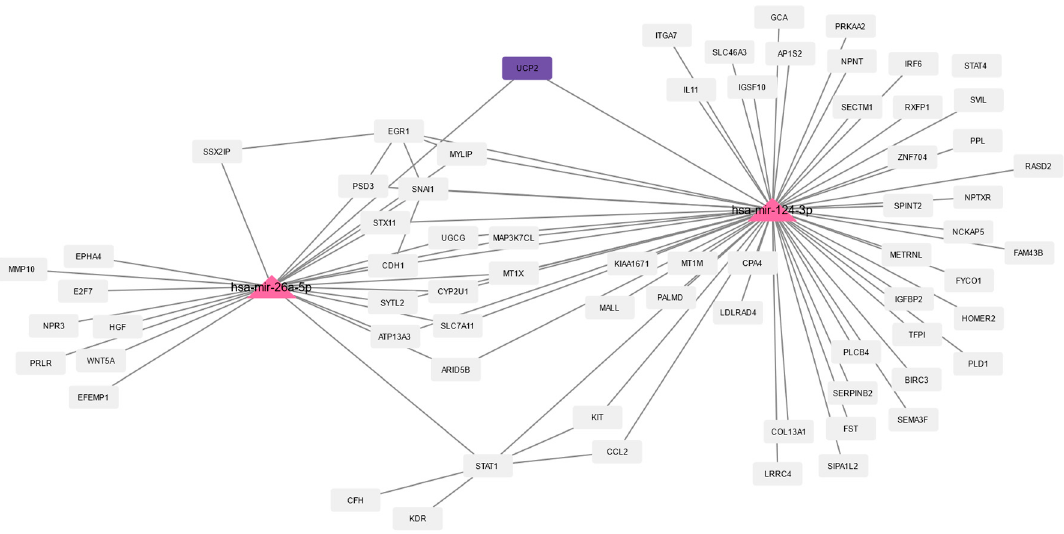
Figure 9. miRNA prediction and network visualization of miRNAs related to UCP2. Predicted